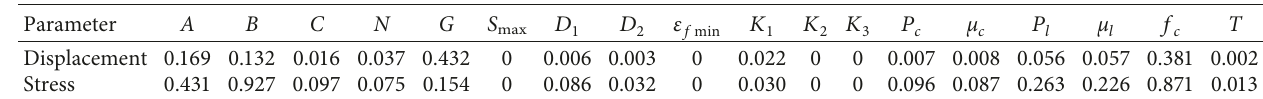
Figure 2: Dimension of RC beam. Table 3: Parameters sensitivity of HJC